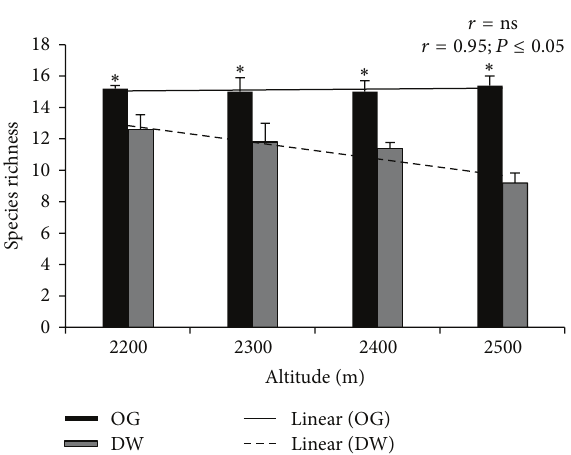
Figure 4: Species richness in old-growth (OG) forest and derived woodland (DW) along altitude. “ ∗ ” represents significant difference between the two forest-use types. “ 𝑟 ” represents Spearman correla- tion. ns indicates no significant correlation.